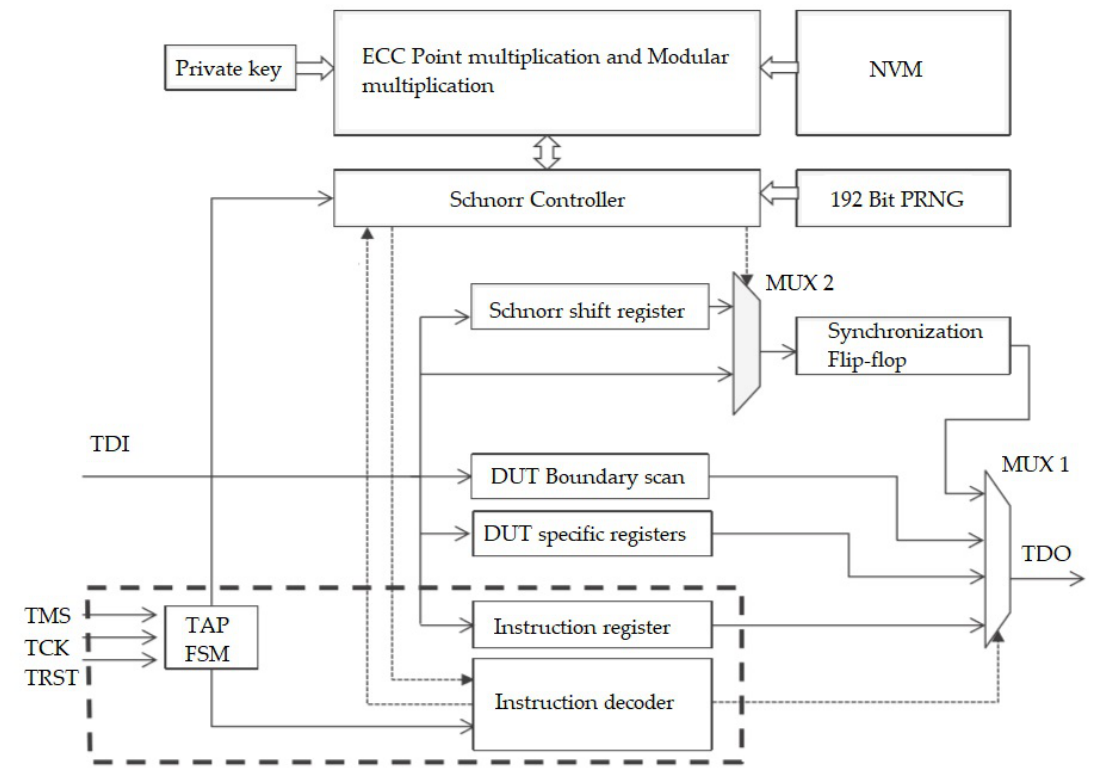
Figure 2. JTAG ECC controller integration block diagram